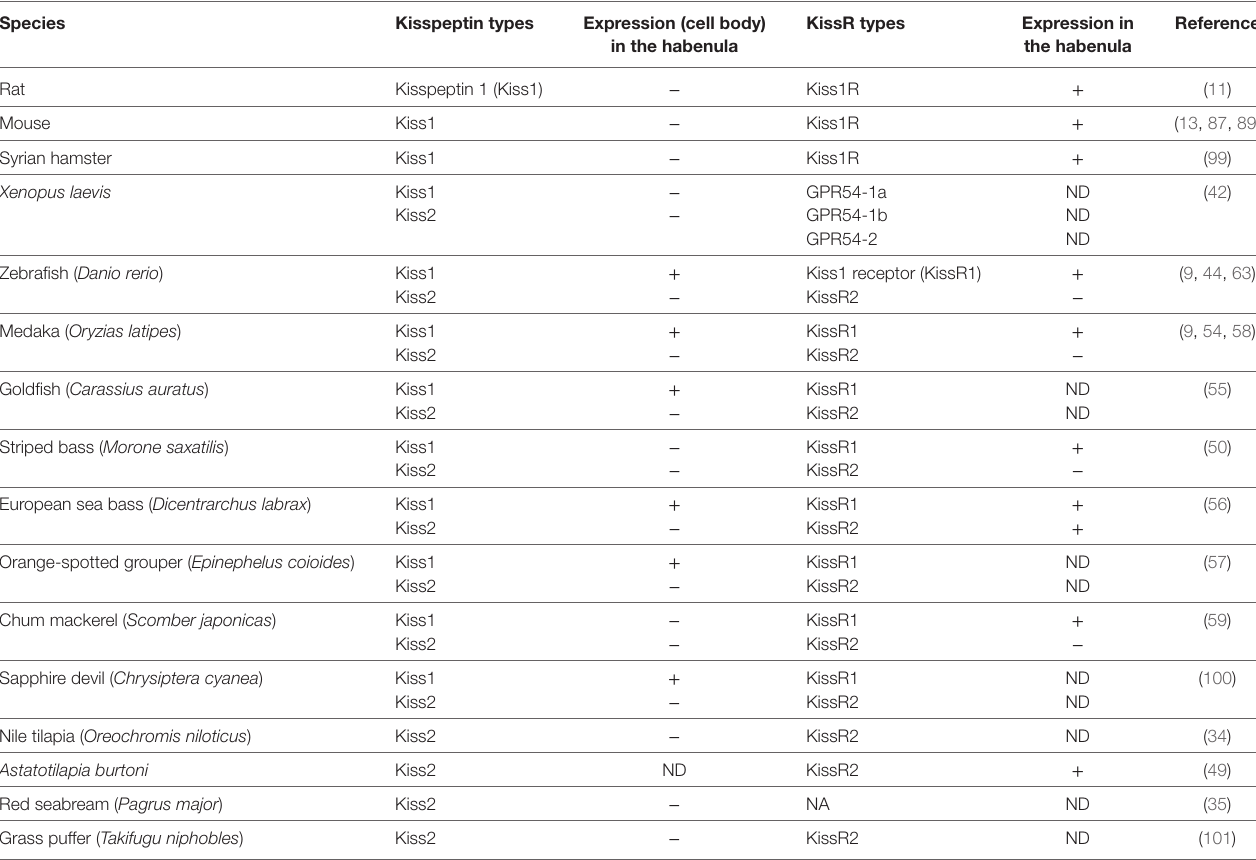
TABLe 1 | Kisspeptin and kisspeptin receptor (KissR) types and their expression in the habenula. Species Kisspeptin types expression (cell body)